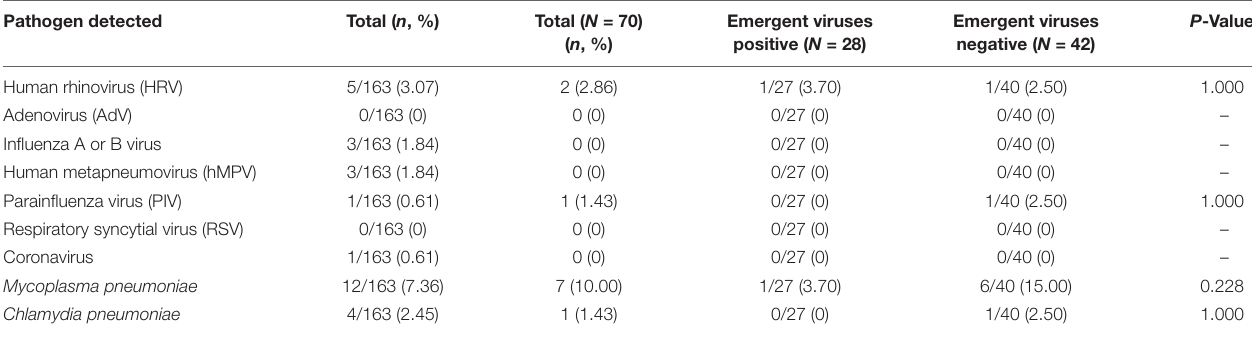
TABLE 3 | The detected pathogens of SARS-CoV-2-Negative community acquired pneumonia patients. Pathogen detected Total ( n ,